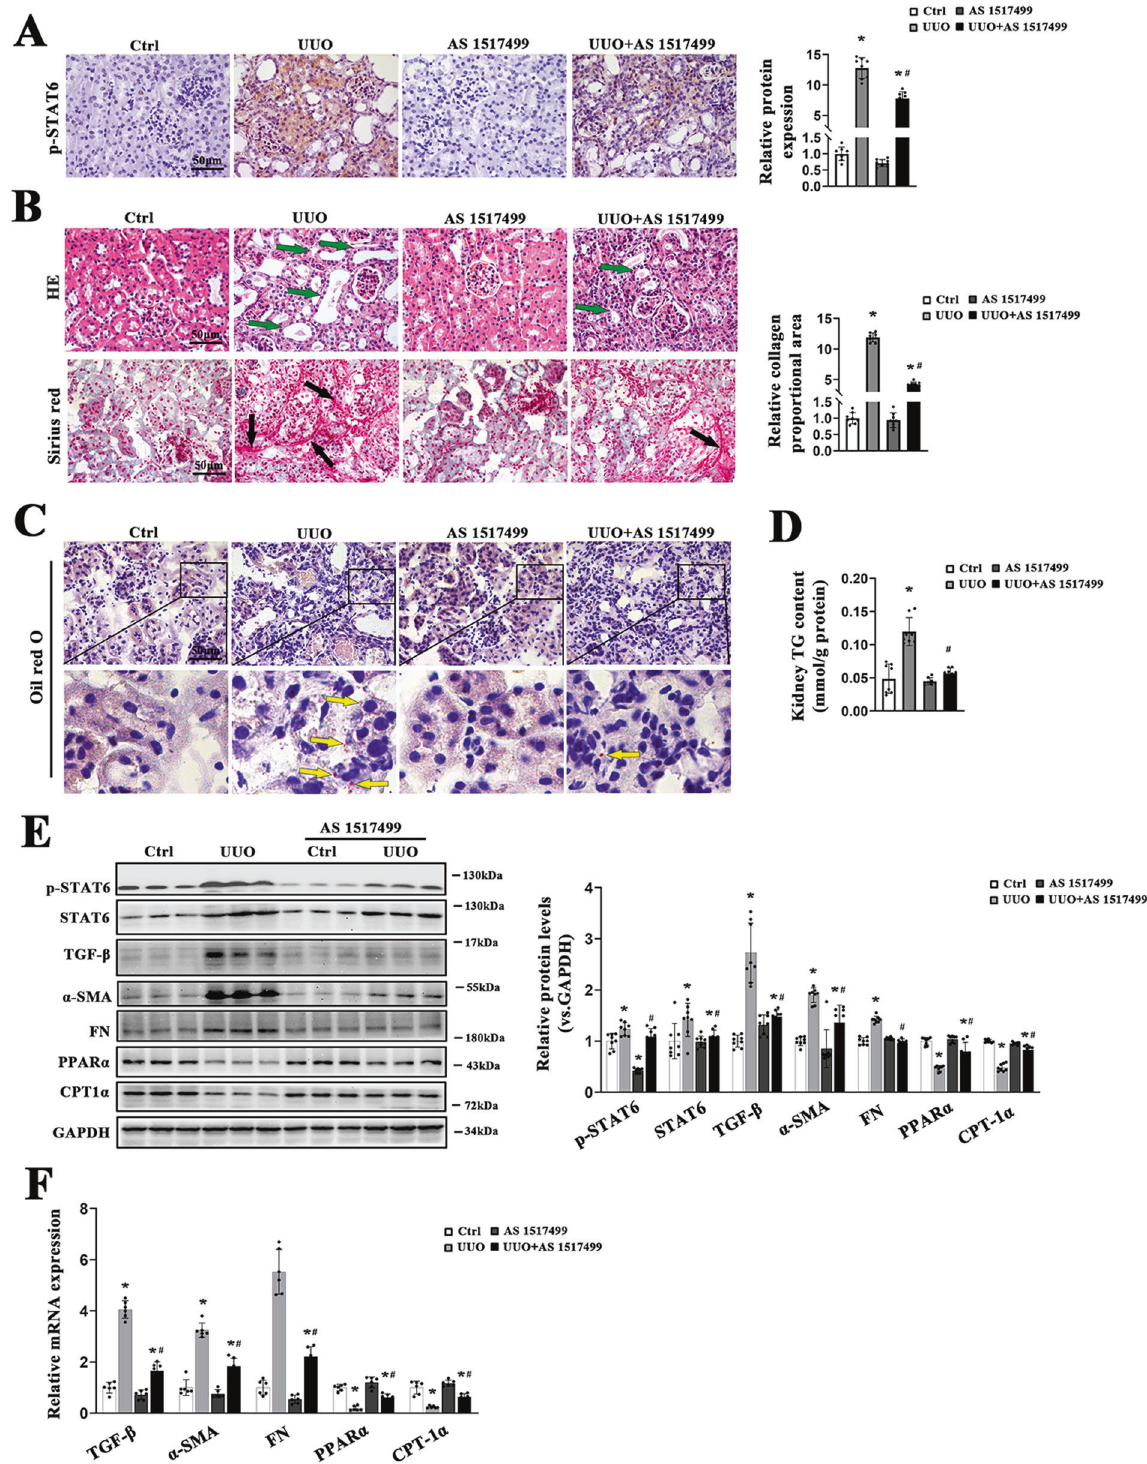
Fig. 6 AS1517499 attenuates aberrant lipid metabolism and tubulointerstitial fi brosis in UUO mice. A Representative micrographs for p-STAT6 staining in the kidney from the indicated groups, and quanti fi cation of relative protein expression in the kidneys from the indicated groups. B Representative Sirius red staining and H&E staining in the kidney from the indicated groups, and quanti fi cation of relative collagen proportion in the kidneys from the indicated groups. C Representative Oil O Red staining in the kidney from the indicated groups. D TG content was determined in the kidneys from the indicated groups. E Kidney tissue lysates from each group were subjected to immunoblot analyses with the indicated antibodies. Representative blots of three independent samples in each group were shown and quanti fi cation of relative protein expression was determined. F The mRNA levels of genes related to lipid metabolism and renal fi brosis in the kidneys from the indicated groups. Results are expressed as the mean ± SD ( n = 6-8, * p < 0.05, UUO vs . Ctrl, # p < 0.05, UUO vs . UUO + AS1517499).